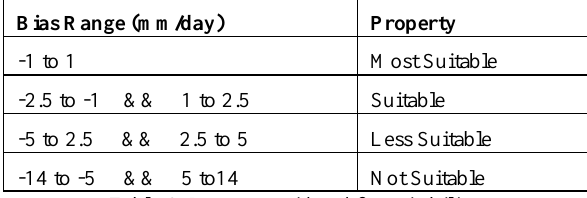
Table 6. Range considered for suitability